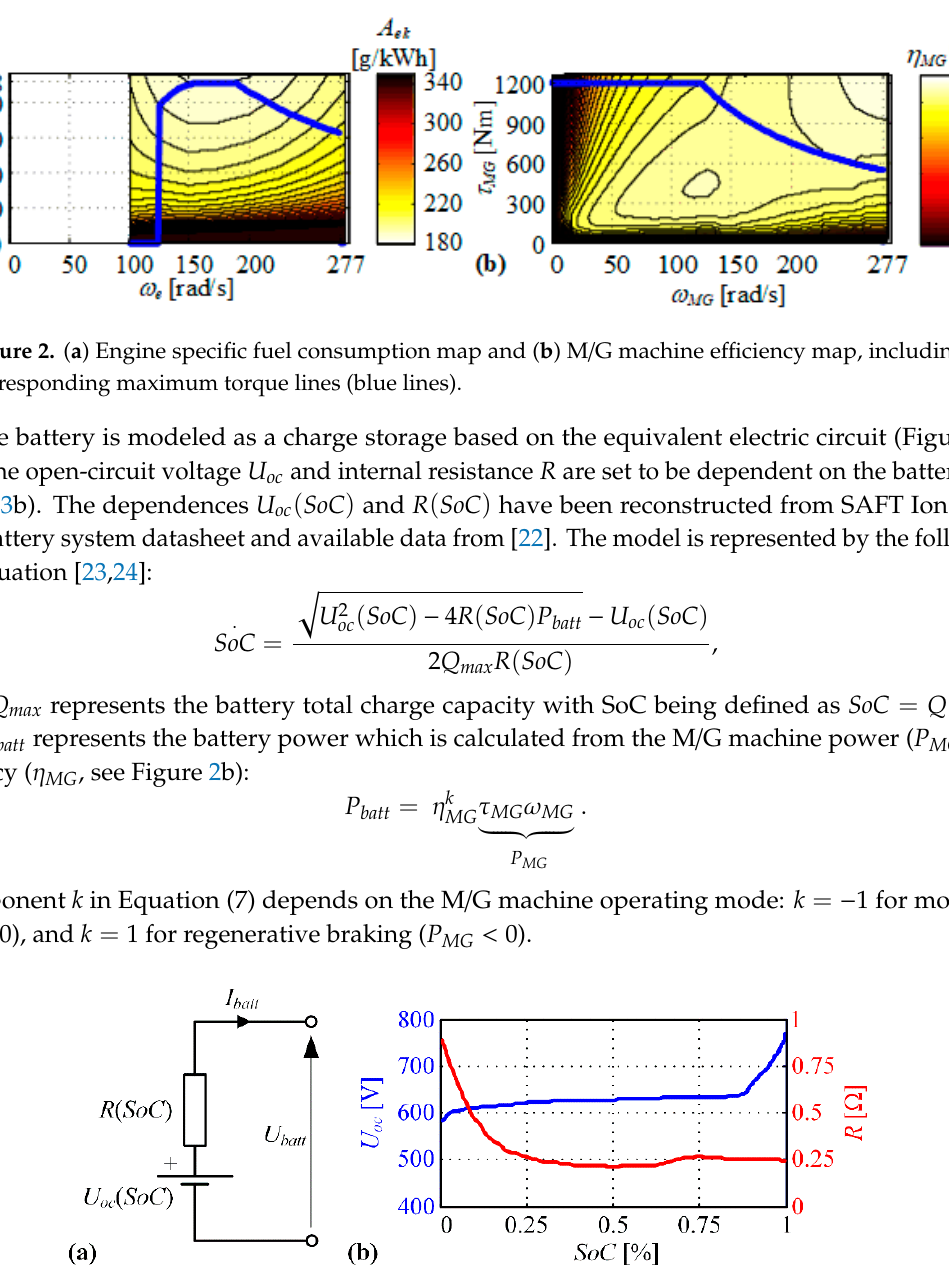
Figure 3. ( a ) Battery equivalent circuit model and ( b ) dependencies of open-circuit voltage U oc reconstructed from and internal resistance R with respect to SoC for LiFePO 4 battery.